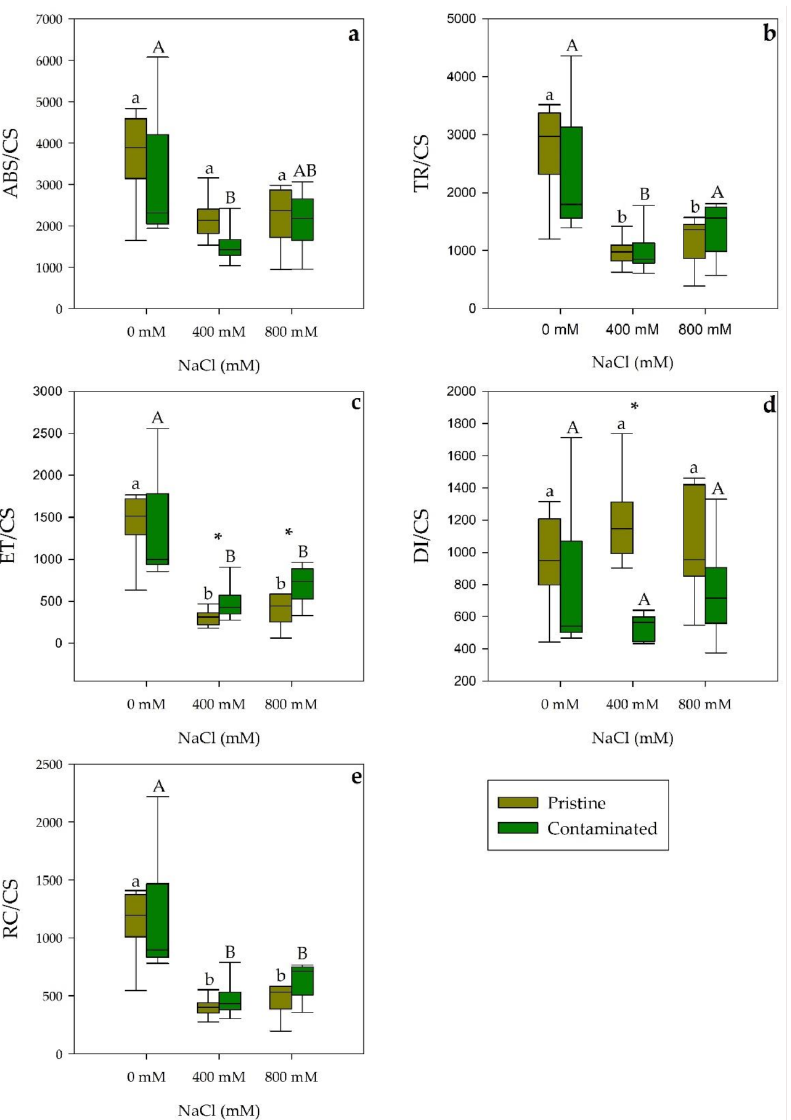
Figure 2. Phenomenological energetic parameters, ( a ) absorbed energy flux (ABS/CS), ( b ) trapped energy flux (TR/CS), ( c ) electron transport energy flux (ET/CS), ( d ) dissipation energy flux (DI/CS), and ( e ) oxidized reaction centers (RC/CS) on a cross-section basis, in S. patens dark-adapted leaves from pristine and heavy metal contaminated sites (average ± standard error, N = 5), along with the tested NaCl concentrations. Letters indicate significant differences between treatments at p < 0.05; asterisks mark significant differences between populations at p <